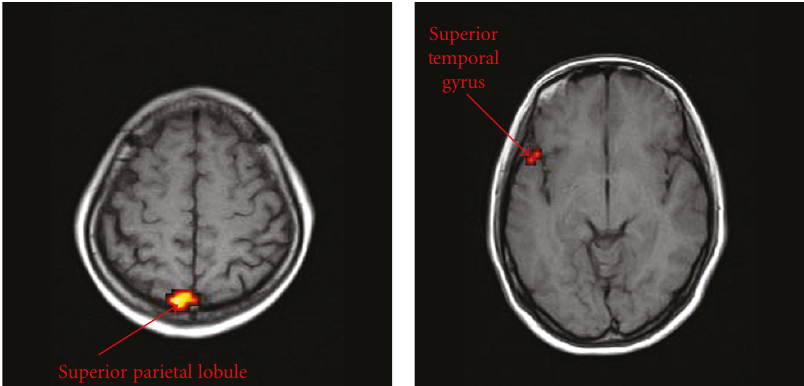
Figure 4: The activation map for the texture perception experiment. The red arrowheads indicate the location of ROI, which is the most strongly activated voxel in their own activation